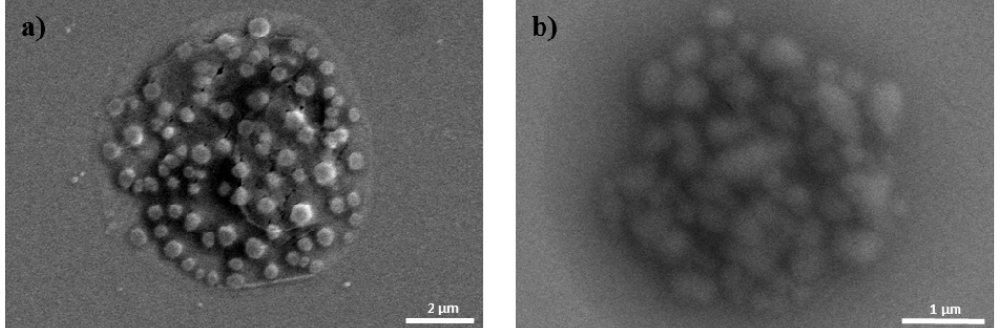
Table 1. The size and zeta-potential of binary and ternary nanocomplexes. Formulation